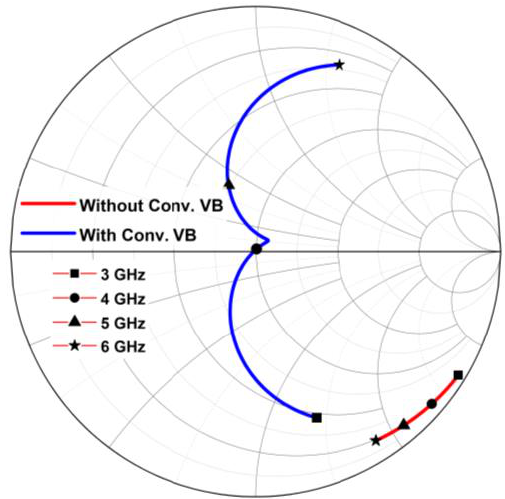
Figure 14. Input impedance ’ s location across frequency with and without conventional VB.